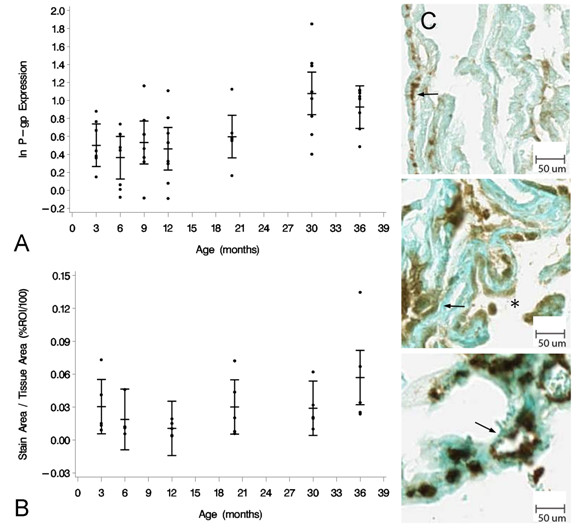
Age-related P-gp expression at the CP. (A) Graph of the log-transformed normalized expression of P-gp with respect to age, n = 8 for each age group. One-way ANOVA revealed a significant increase (p = 0.0005) with age on P-gp expression. Significance was reached between 30 mo and 3, 6, 9, and 12 mo, and between 36 mo and 6 mo. Error bars represent 95% confidence intervals for the means. (B) Semi-quantitative IHC for P-gp expression. Stain area to tissue area ratio was not significantly different (p > 0.05) for the six age groups, n = 5 per age group. (C) IHC of P-gp expression at 3 mo (top), 20 mo (center), and 36 mo (bottom) old rats. Majority of staining is localized to the basolateral membrane (arrows), though on occasion it is seen along the apical membrane (asterisk).